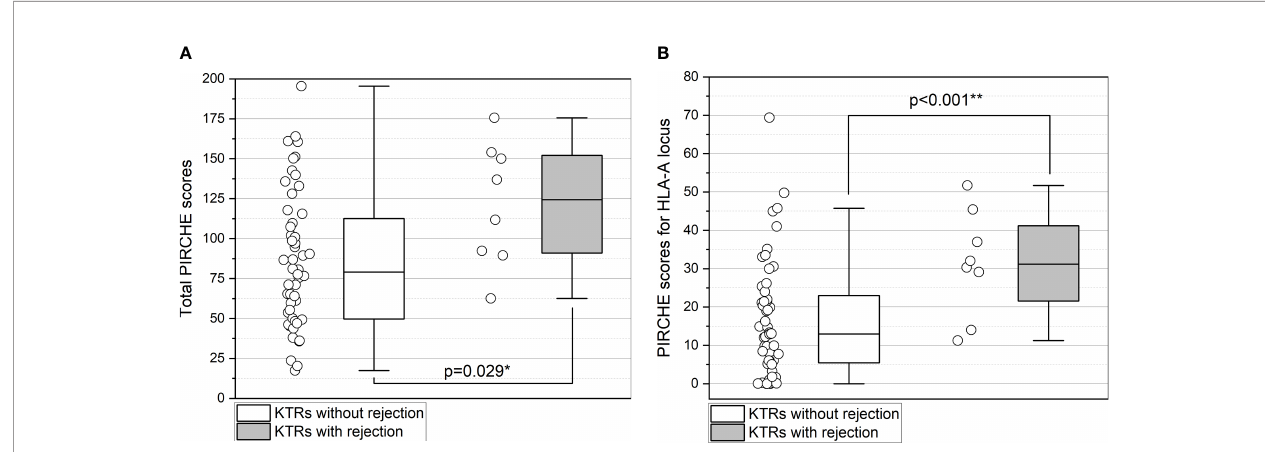
FIGURE 3 | (A, B) Higher total PIRCHE scores (A) and PIRCHE scores for HLA-A locus mismatches (B) among KTRs with BLR who develop future TCMR/ABMR. Boxplots show median, interquartile range (IQR), and 95 th percentile. ** signi fi cance level